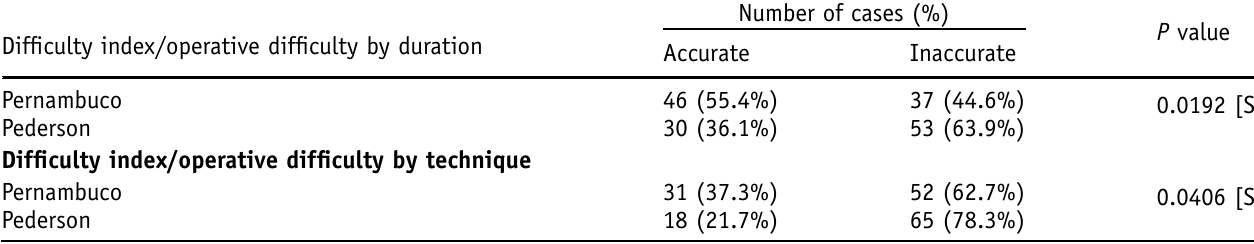
Table IV. The accuracy of dif fi culty indexes/operative dif fi culty. Dif fi culty index/operative dif fi culty by